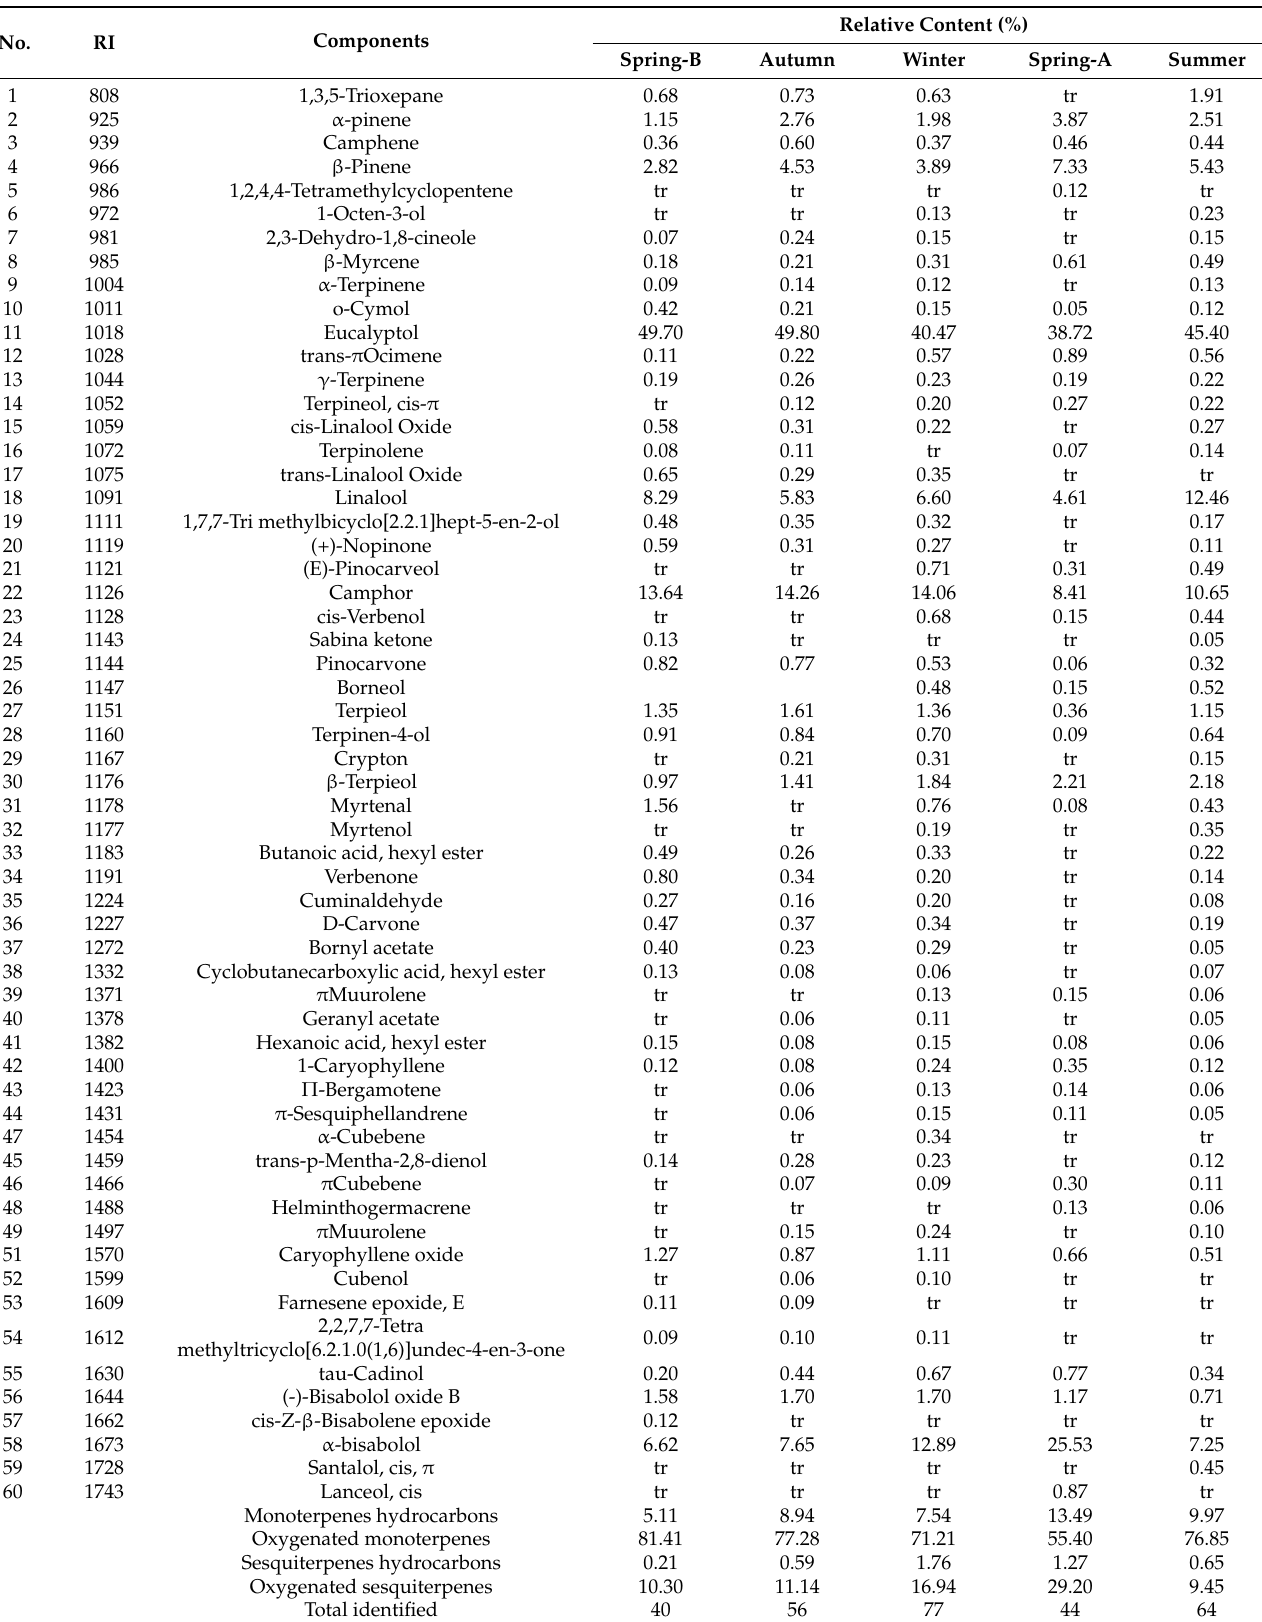
Table 2. Essential oil composition of Lavandin isolated from fresh flower mass during different